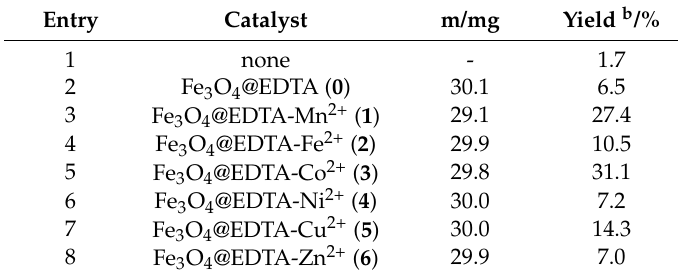
Table 1. Solvent-free MW-assisted oxidation of 1-phenylethanol to acetophenone in the absence and presence of 0 – 6 MNPs as catalysts .a . MW: microwave. Entry Catalyst m/mg Yield b /% 1 none - 1.7 2 Fe 3 O 4 @EDTA ( 0 ) 30.1 6.5 Fe 3 O 4 @EDTA-Mn 2+ ( 1 ) 29.1 Fe 3 O 4 @EDTA-Fe 2+ ( 2 )